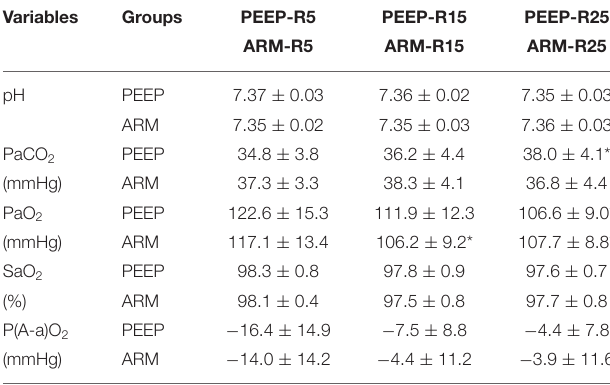
TABLE 2 | Blood gas measurements during 5–25min of recovery from isoflurane-anesthetized dogs mechanically ventilated with tidal volume of 8mL kg − 1 submitted to recruitment maneuver (ARM group, n = 11 ) or without recruitment maneuver (PEEP group, n = 10 ) and use of 5 cm H 2 O of positive end-expiratory pressure